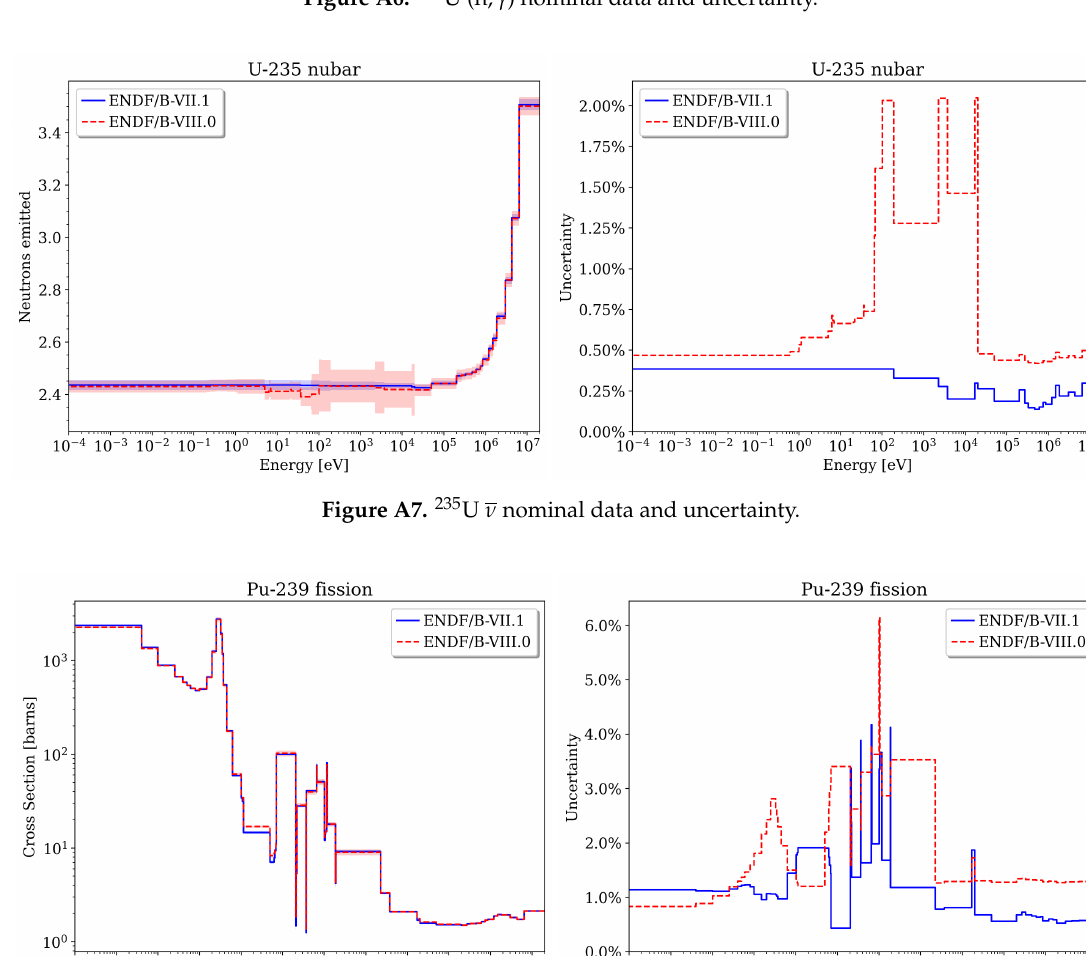
Figure A6. 235 U (n, γ ) nominal data and uncertainty.